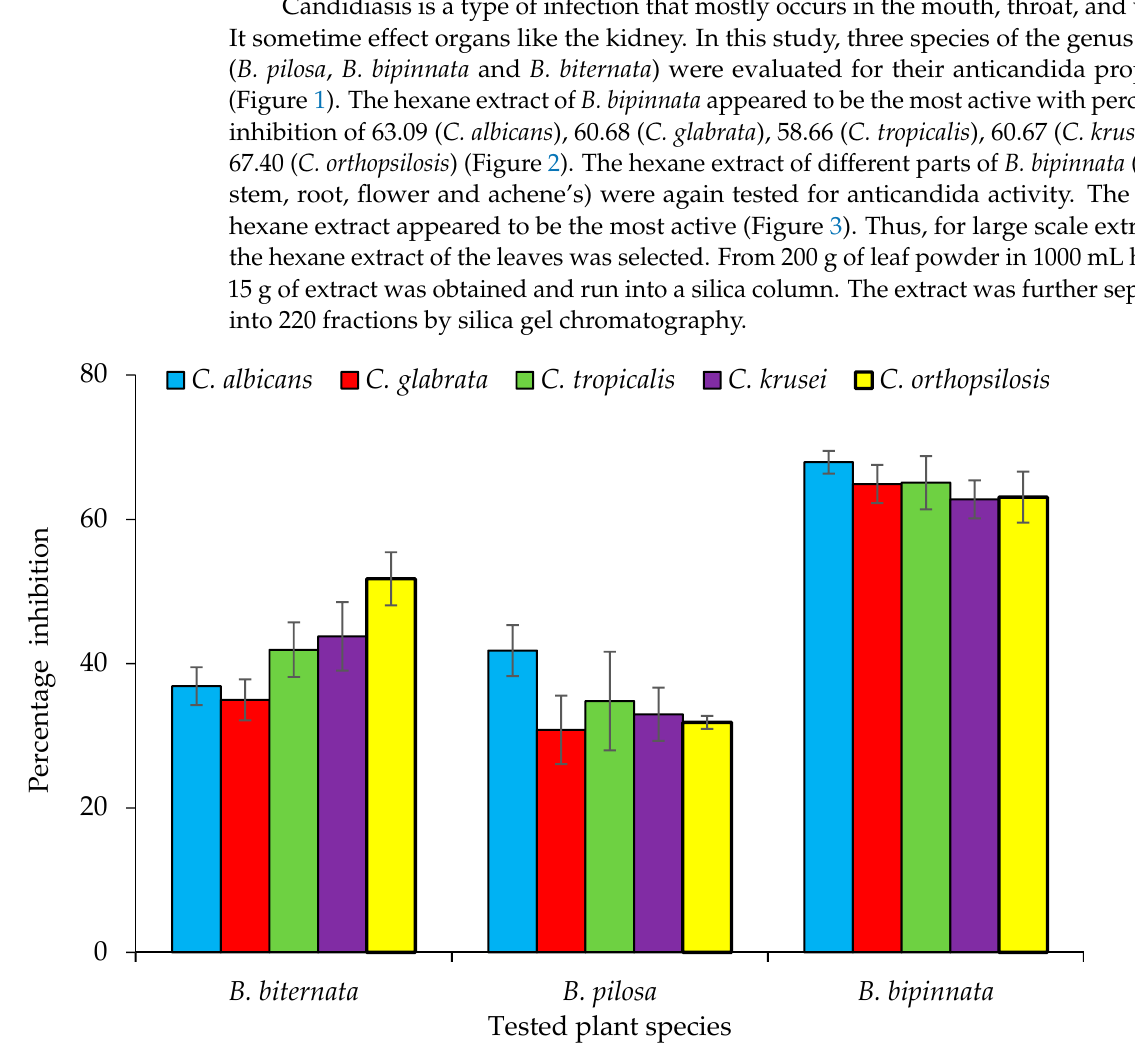
Figure 1. Anticandida activity of Bidens bipinnata, Bidens pilosa and Bidens biternata .